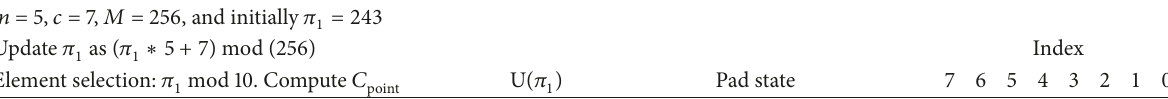
Table 4: Working of the GRKG method (U: updated, SPE: selected pad